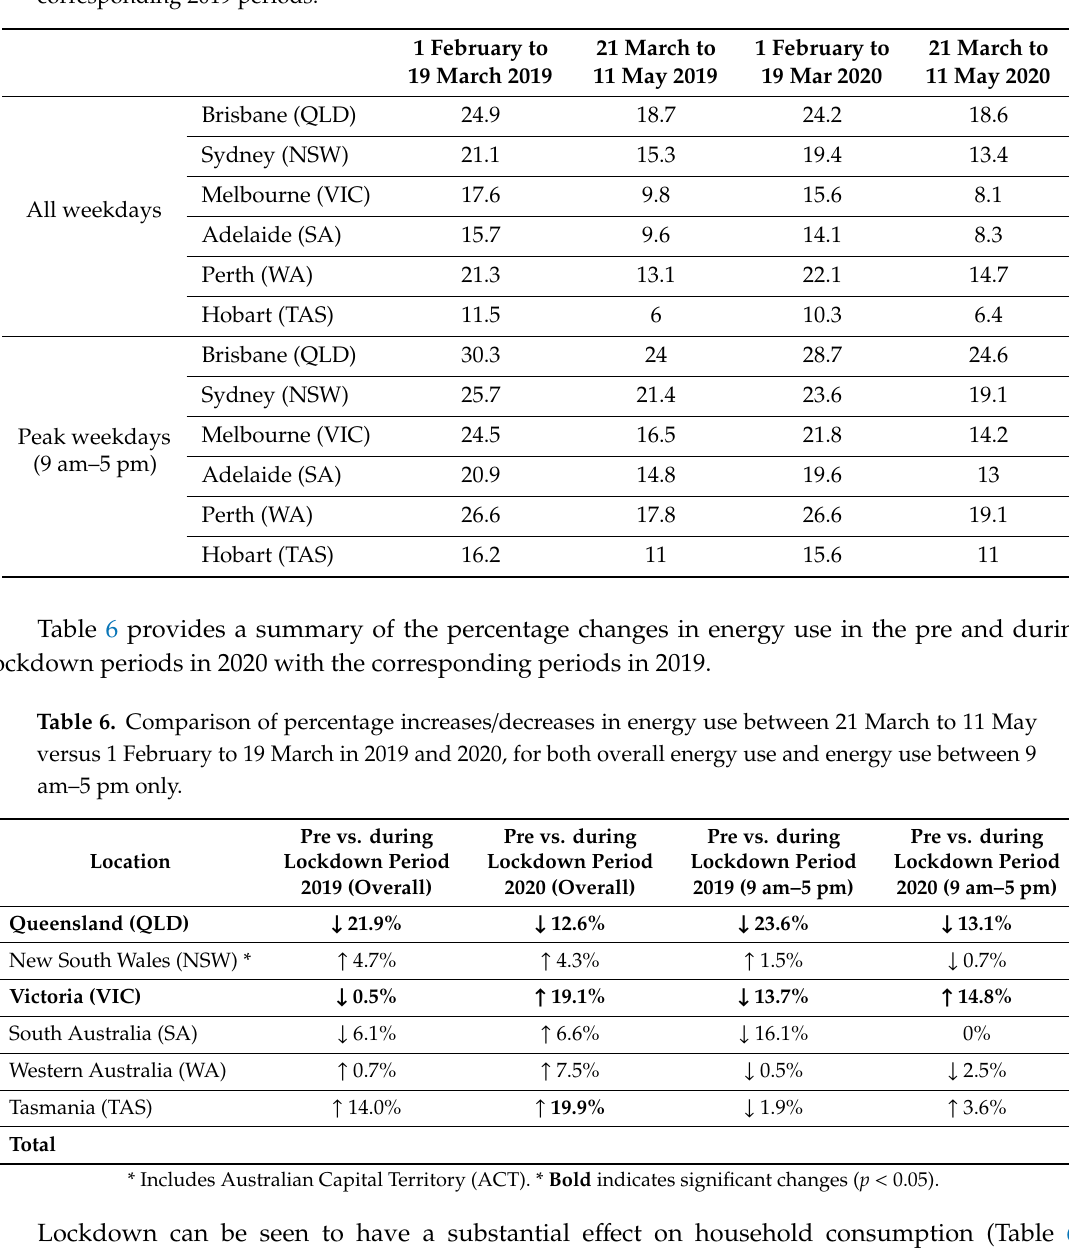
Table 5. Hourly temperature (UTCI) in six state capitals, pre and post COVID-19 lockdown, and corresponding 2019 periods.